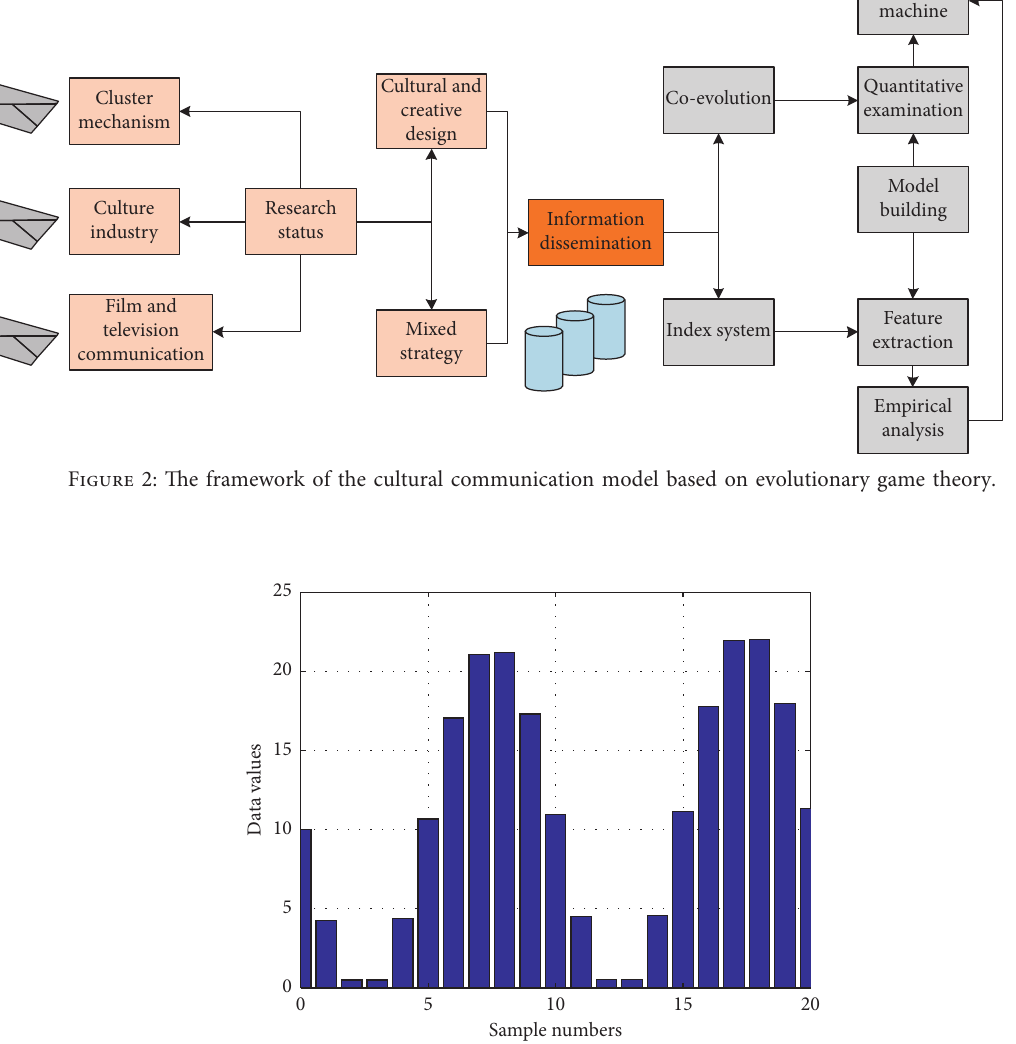
Figure 3: Simulation of cultural transmission data